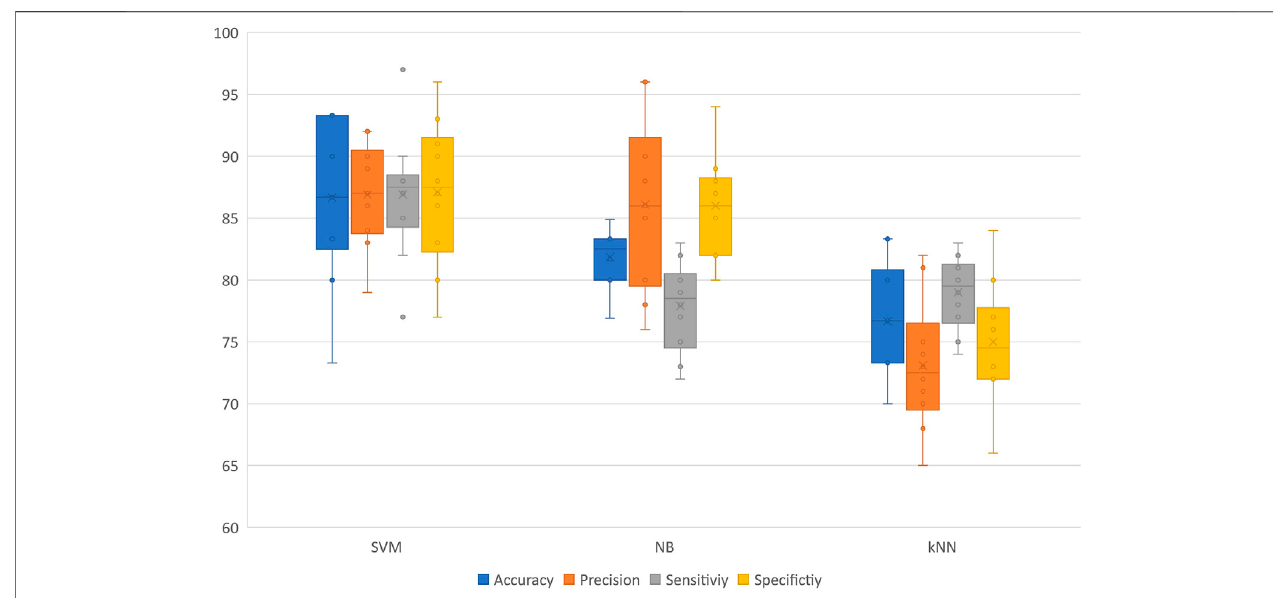
FIGURE 6 | Comparison of classi fi ers accuracy, precision, sensitivity, and speci fi city based upon 10 v-fold cross validation data.